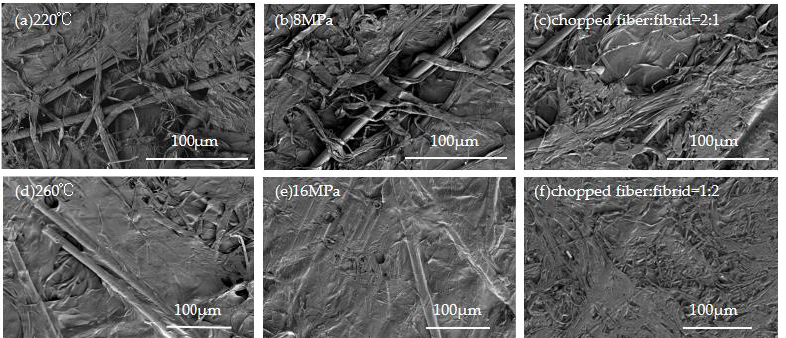
Figure 10. Micromorphology of insulating paper with different hot pressing temperature, pressure, and fiber content. and fiber